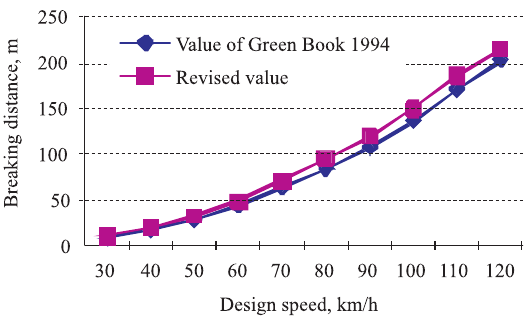
Fig. 4. Comparison of the two braking distances